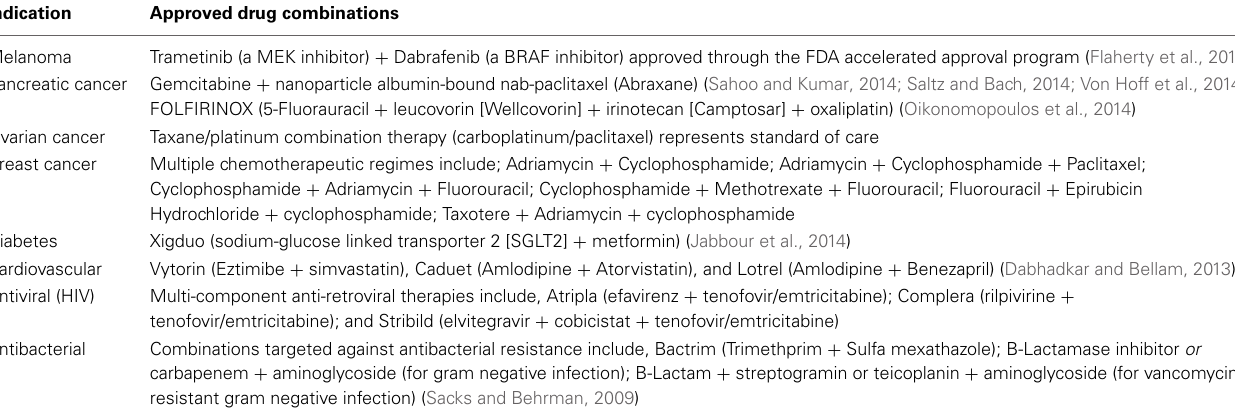
Table 1 | Examples of drug combinations approved for clinical use across disease indications. Indication Approved drug